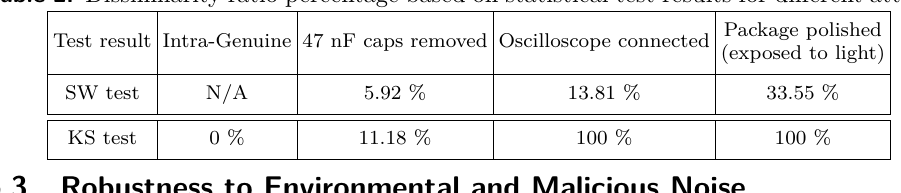
Table 2: Dissimilarity ratio percentage based on statistical test results for different